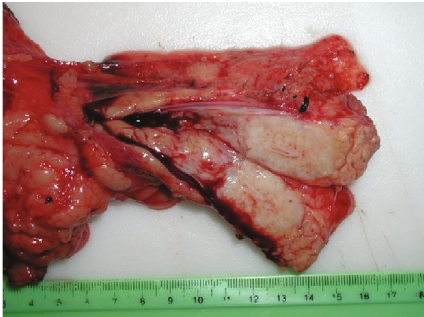
Figure 1: Surgically resected specimen: pancreatic tumor (gross